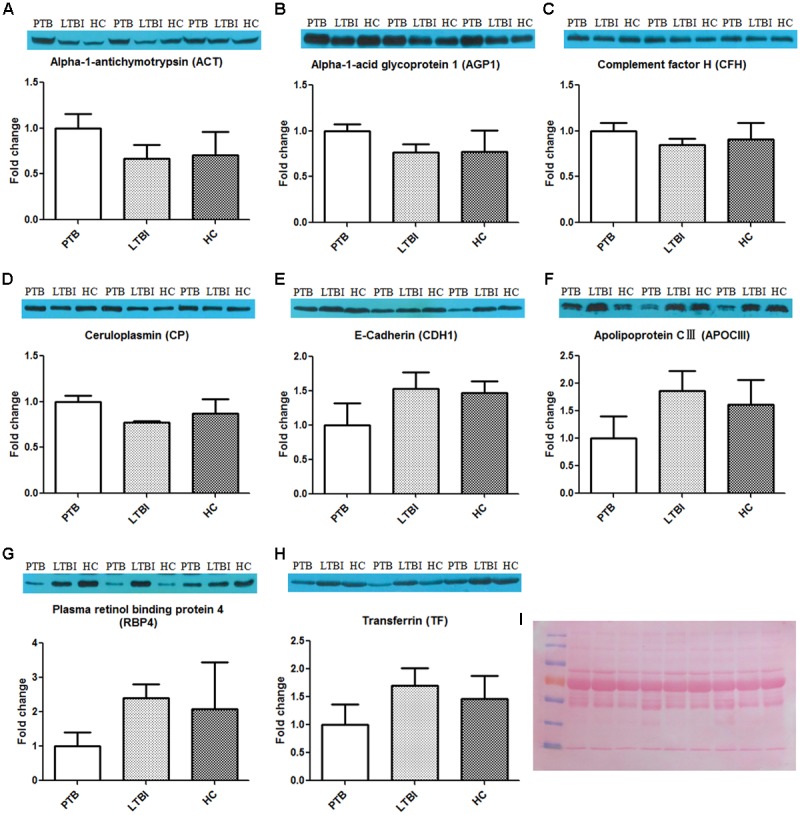
Validation of the differentially expressed proteins by western blot. The eight differential proteins were selected to be validated by western blot, using the nine pooled samples in the discovery set. All these proteins showed the same expression pattern with proteomics analysis. ACT (A), AGP1 (B), CFH (C), and CP (D) were up-regulated in the PTB group when compared with the LTBI and HC groups. CDH1 (E), APOCIII (F), RBP4 (G), and TF (H) were down-regulated in the PTB group when compared with the LTBI and HC groups. (I) The nitrocellulose filter membranes were stained with Ponceau S to ensure equal loading between each sample in western blot analysis. PTB, pulmonary TB; LTBI, latent tuberculosis infection; HC, healthy control.